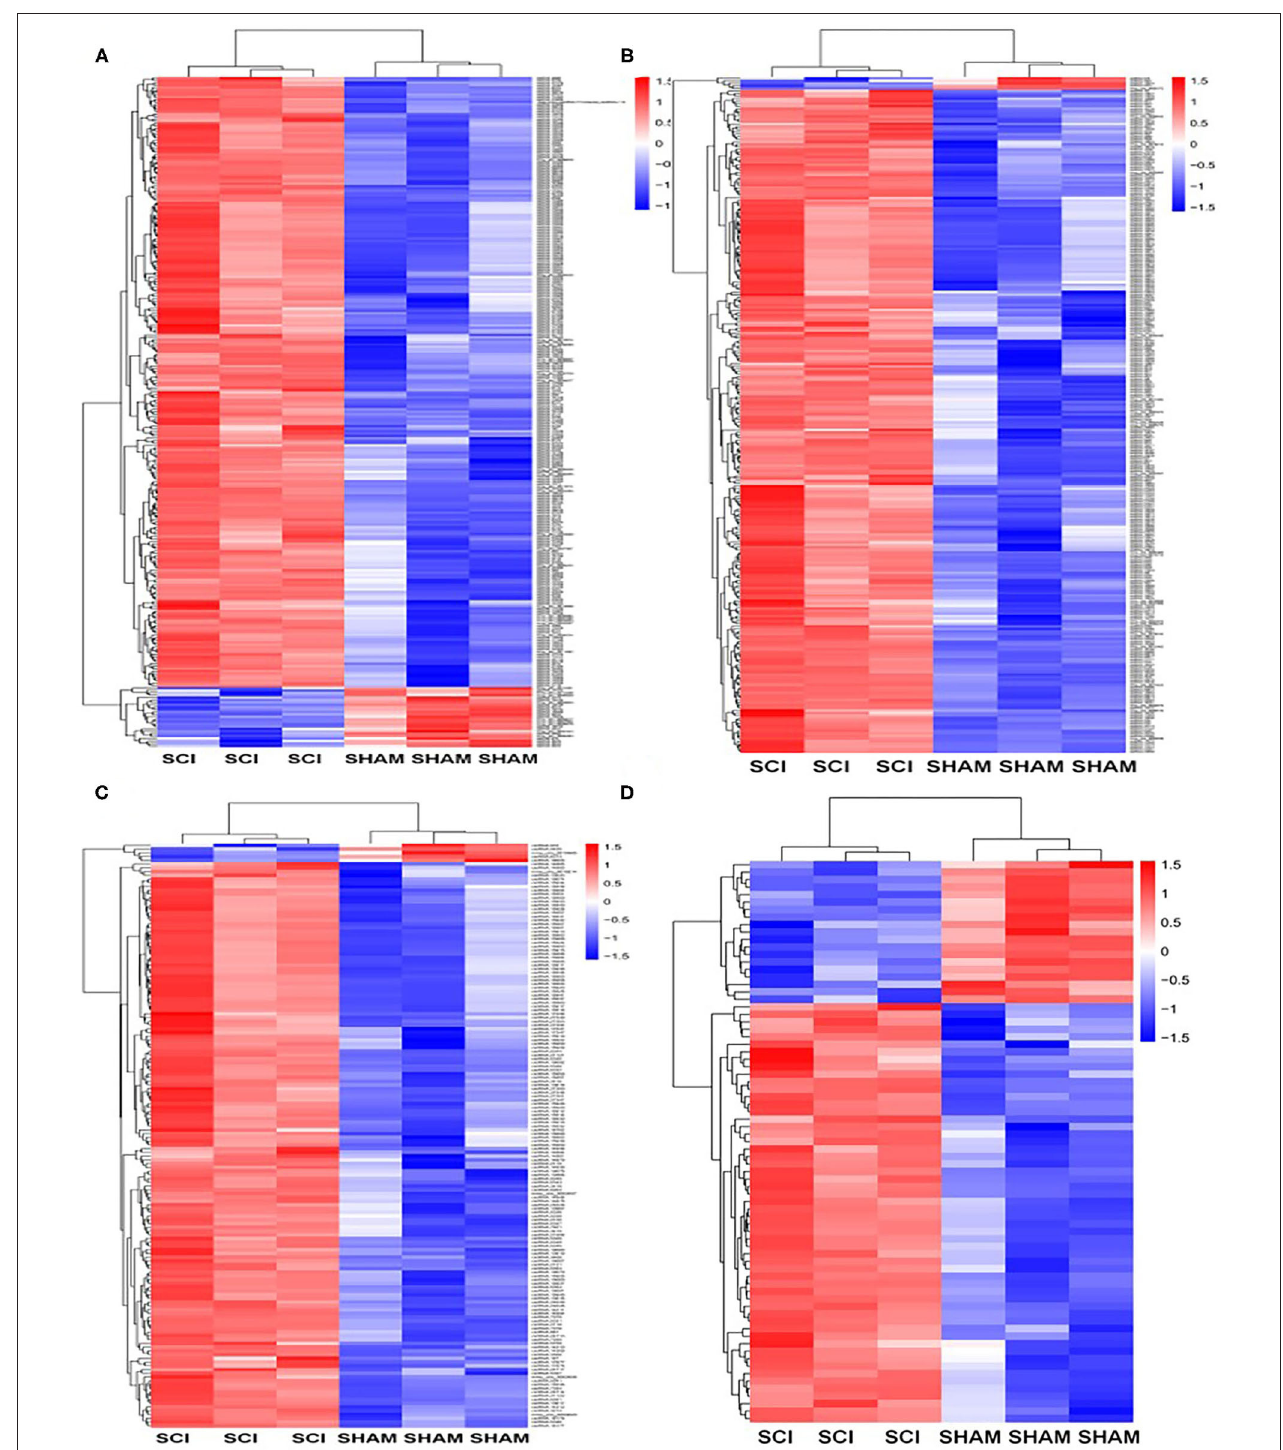
FIGURE 6 | GO analysis for genes and circRNAs related to vascular endothelial proliferation, migration, and angiogenesis. (A) The heat map of GO analysis mRNAs ( > 2-fold change, p < 0.01) enriched for the biological processes, cellular components, and molecular function associated with vascular endothelial proliferation. (B) Heat map of GO analysis mRNAs ( > 2-fold change, p < 0.01) enriched for biological processes, cellular components, and molecular function associated with vascular endothelial migration and angiogenesis. (C) The heat map of GO analysis mRNAs ( > 2-fold change, p < 0.01) enriched for the biological processes, cellular components, and molecular function associated with vascular endothelial angiogenesis. (D) The heat map of associated circRNAs ( > 2-fold change, p < 0.01) based on GO analysis of mRNAs.